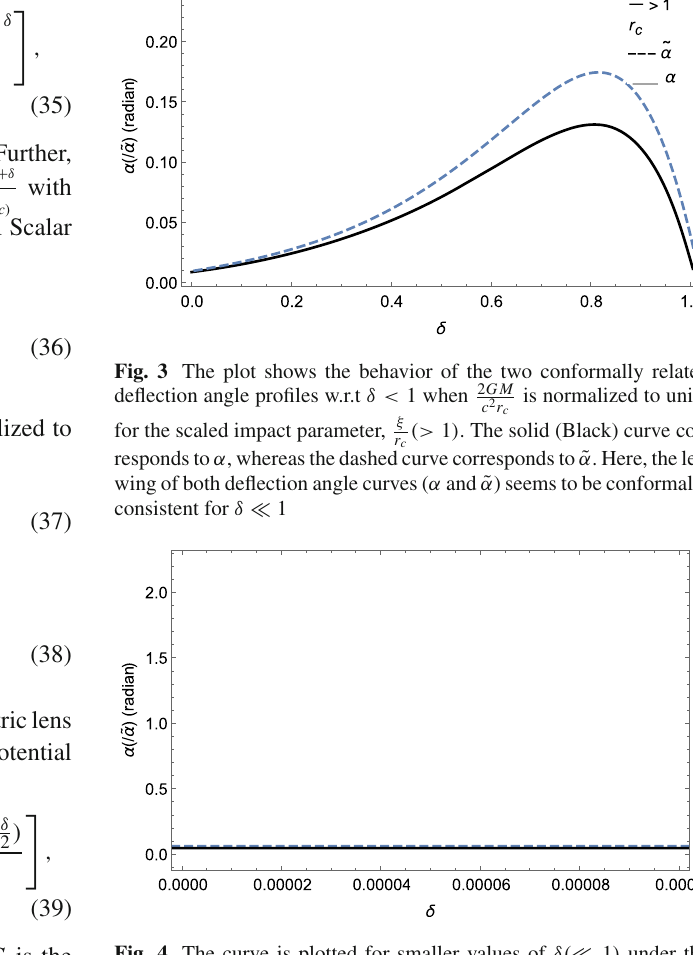
Fig. 4 The curve is plotted for smaller values of δ( (cid:4) 1 ) under the convention used in Fig. 3. It is interpreted from the curve that the profile of deflection angle seems to be observationally as well as conformally consistent, i.e., the profile of the two deflection angles ( α and ˜ α ) are conformally